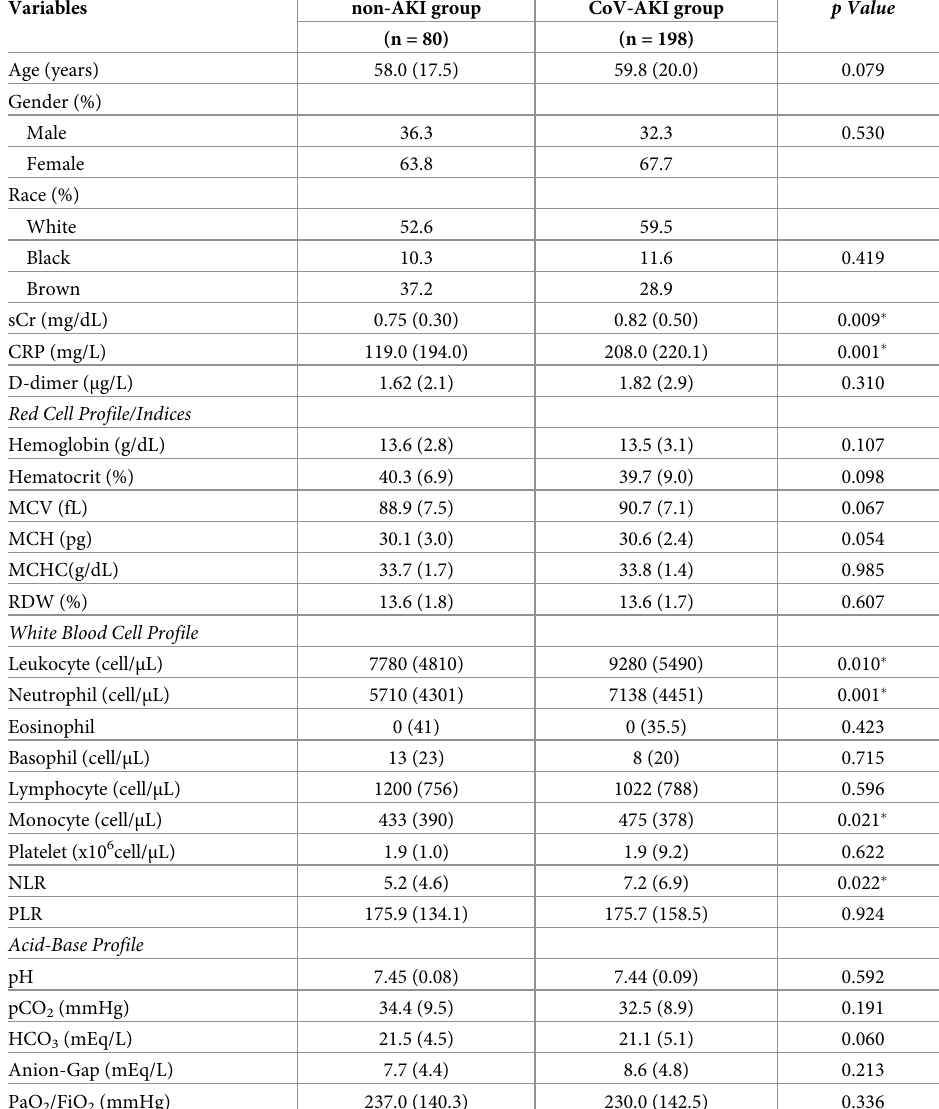
Table 1. Demographic and biochemical data at hospital